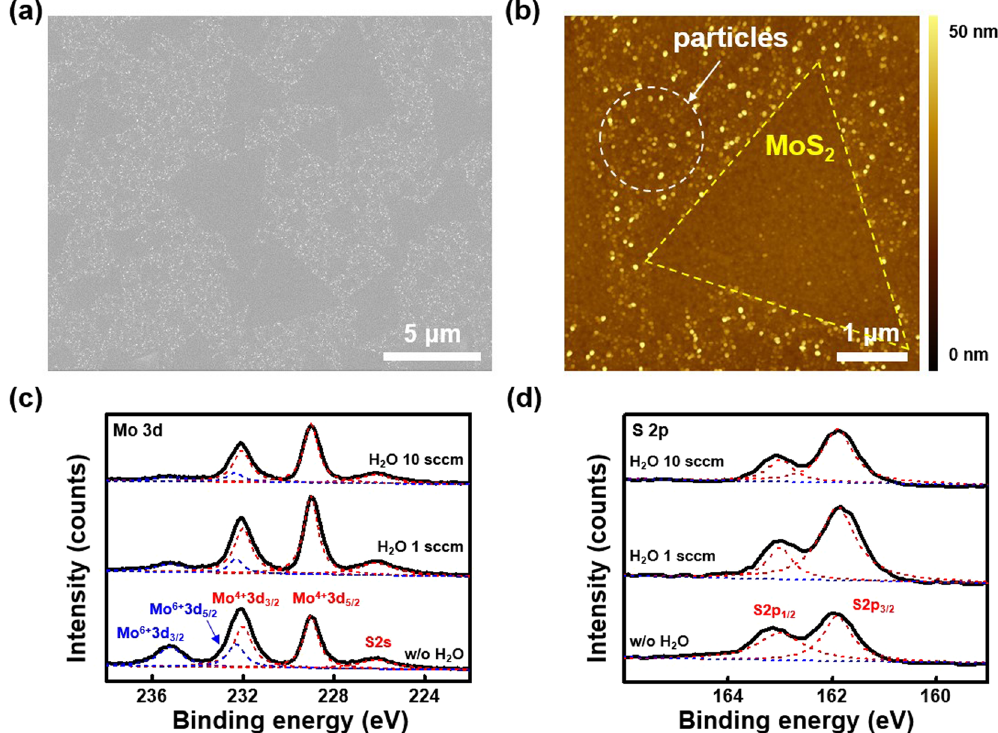
Figure 3. Effect of water supply II: removal of molybdenum oxides. ( a ) SEM, ( b ) AFM images of as-grown MoS 2 flakes without the water supply. Unresolved particles are distributed on the whole region. ( c , d ) XPS core level spectra of ( c ) Mo 3d and ( d ) S 2p for three MoS 2 specimens: without (w/o) water, H 2 O 1 sccm, and H 2 O 10 sccm, respectively. The characteristic peaks of Mo 4 + 3d 3/2 , Mo 4 + 3d 5/2 , S 2s, S 2p 1/2 , and S 2p 3/2 correspond to MoS 2 whereas the peaks of Mo 6 + 3d 3/2 and Mo 6 + 3d 5/2 correspond to molybdenum